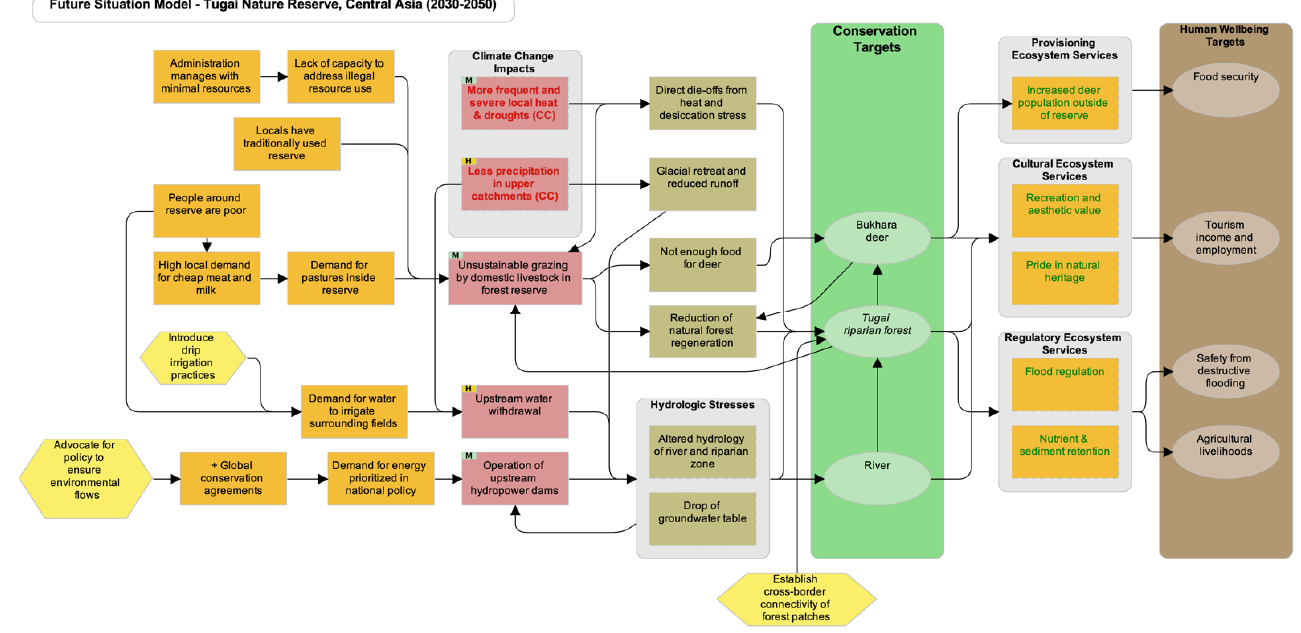
Figure 6. Central Asian Tugai Nature Reserve Future Situation Model Showing Final Strategies (Yellow Hexagons) and Threat Ratings Indicated in Upper Left Corner of Threats (V = very high, H = high, M = medium, L = low) (adapted with permission from ref. [25]). Table 2. Example Relative Rating of Potential Strategies from Central Asia Tugai Nature Reserve (adapted with permission from ref. [25]). Higher numbers indicate higher ranking for each criterion and total scores are a summation of the ranking by criterion and priority strategies in